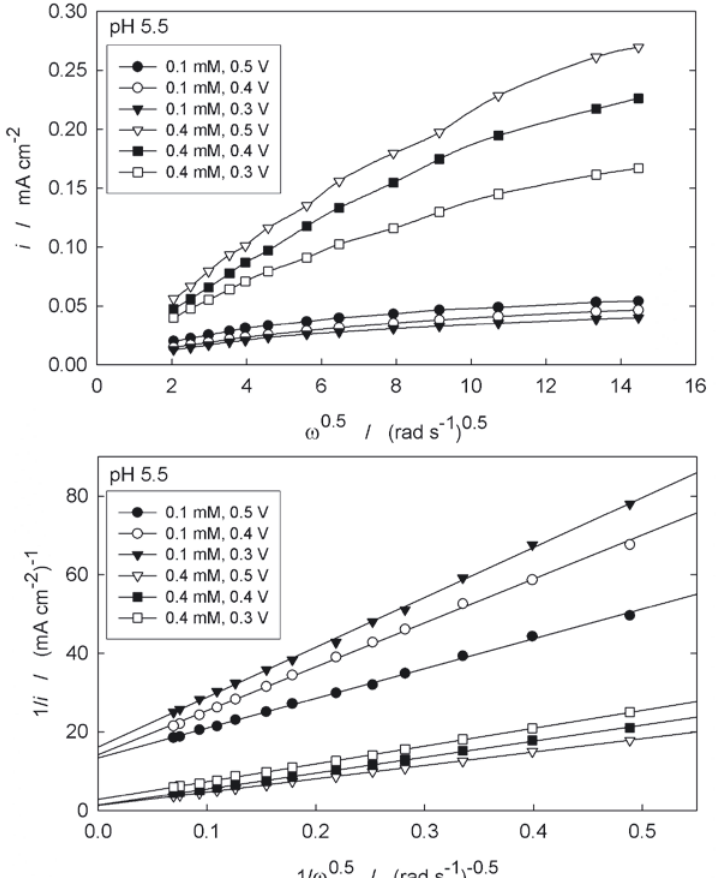
Figure 3. Treatment of the data obtained at Prussian blue modified electrode in pH 5.5 solution for different ascorbate concentrations and different electrode potentials (as indicated) in Levich (top) and Koutecky-Levich (bottom)